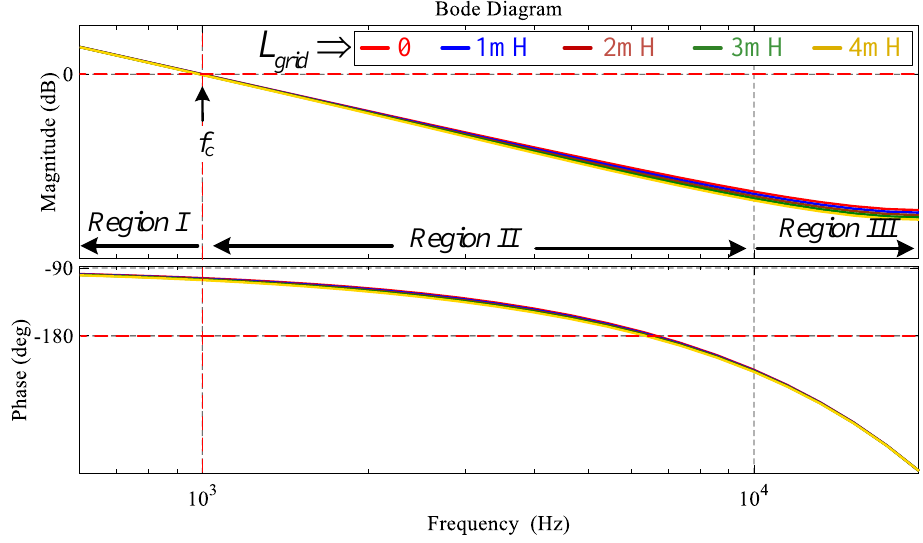
Figure 13. Loop gain frequency response characteristics of the L filter type GcI with RESO-based ADRC under grid impedance variation.